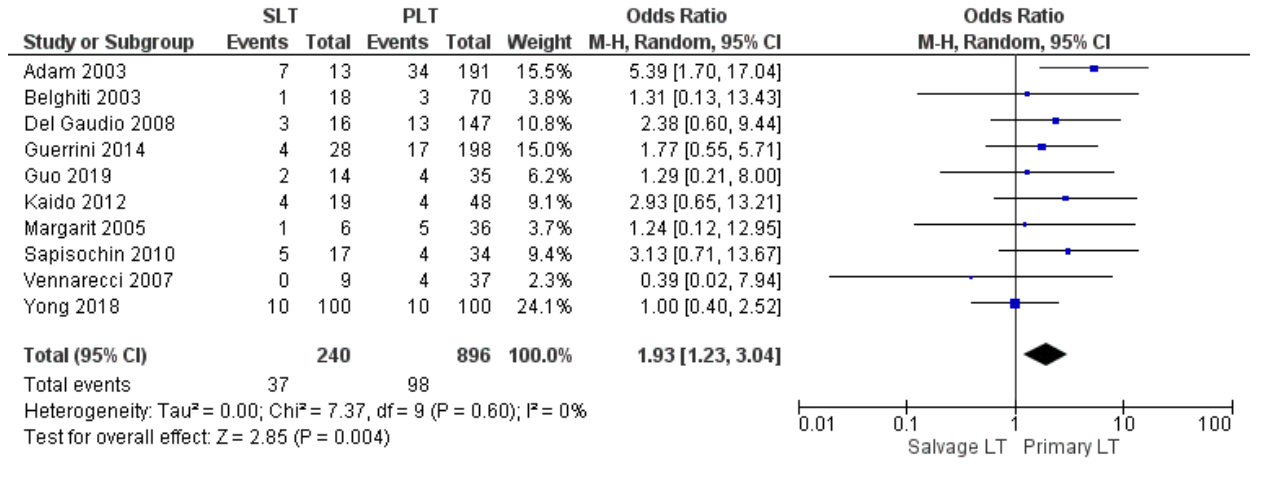
Figure 19. HCC recurrence rate.